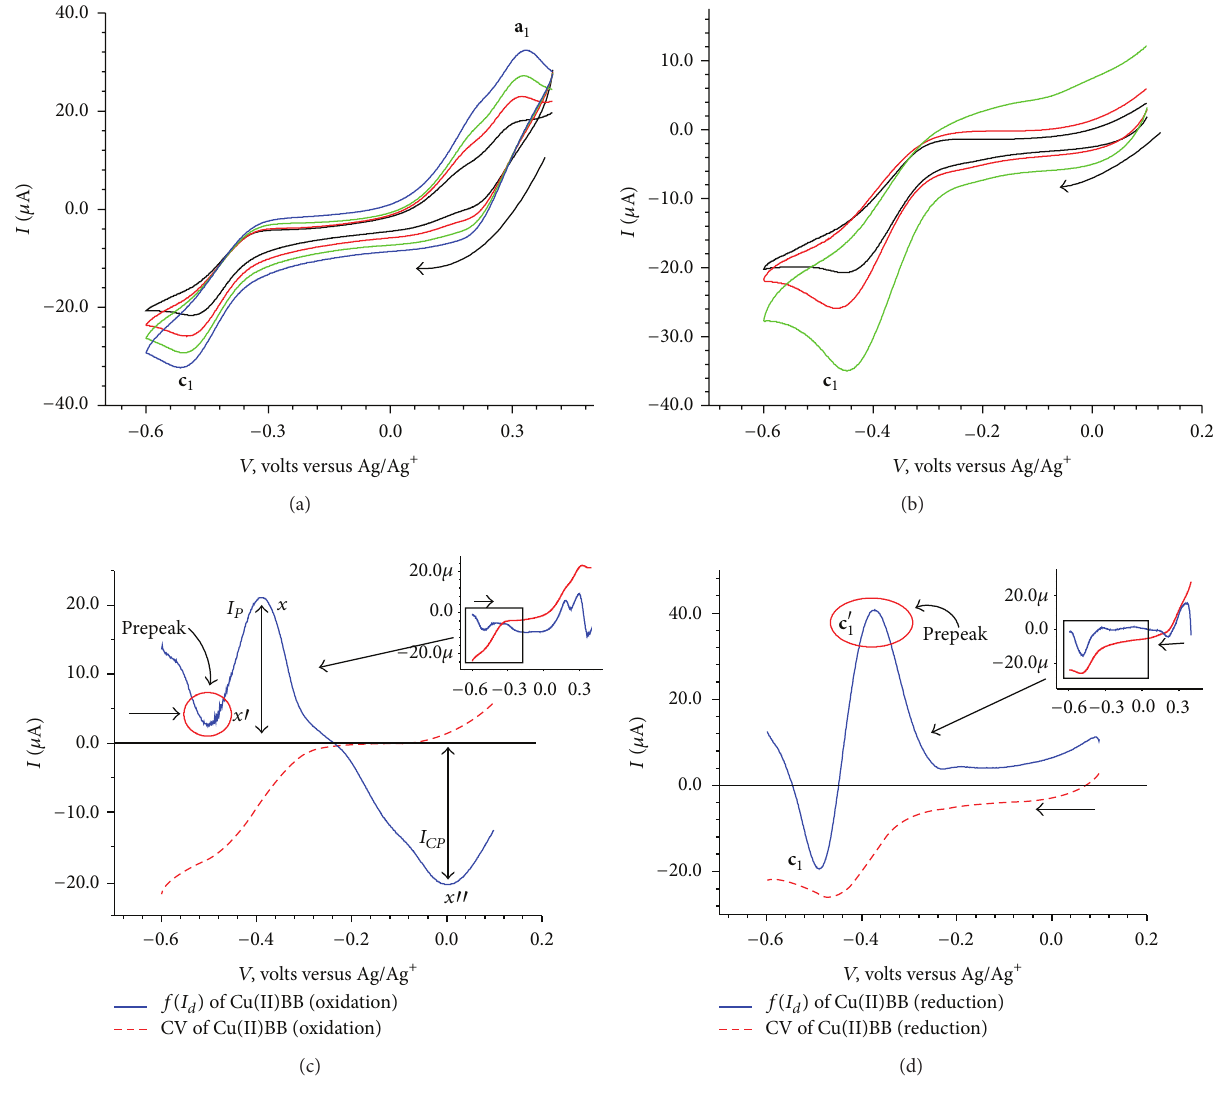
Figure 7: (a) and (b) cyclic voltammogram of Cu(II)BB with increasing scan rate 100mV/sec to 400mV/sec, (c) 𝑓(𝐼 𝑑 ) elimination plot for the oxidation of Cu(II) complex, and (d) 𝑓(𝐼 𝑑 ) elimination plot for the reduction of Cu(II)